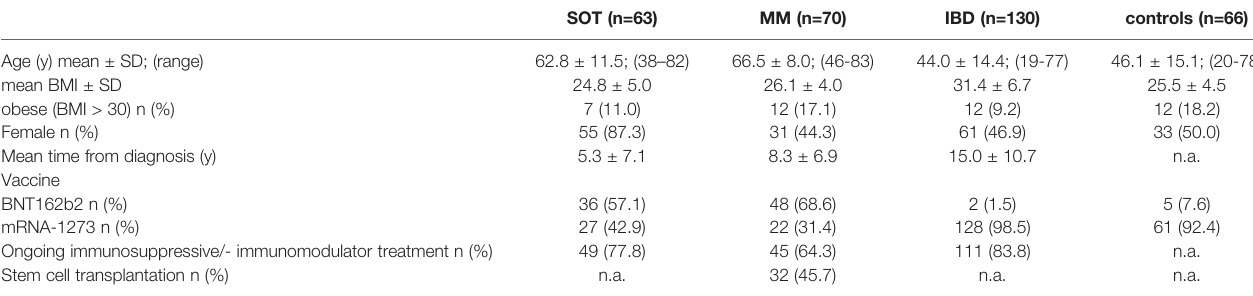
TABLE 1 | Description of the study population (n=263 patients, n=66 controls).